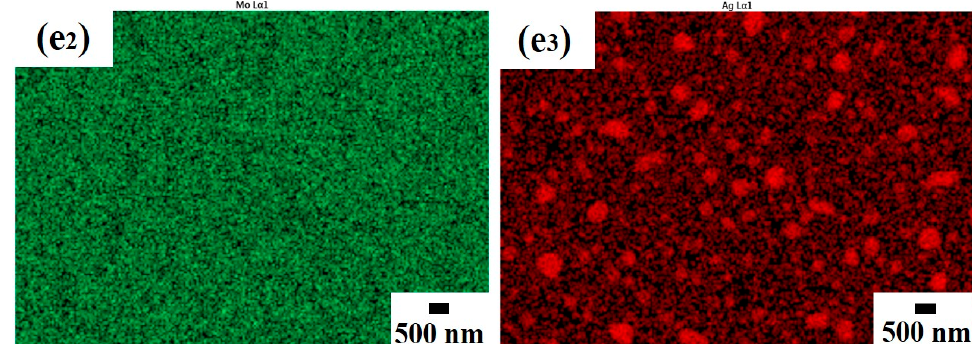
Figure 2. The scanning electron microscope (SEM) images of the Mo-48.2% Ag films before and after annealing: ( a ) room temperature; ( b ) 160 °C ; ( c ) 260 °C ; ( d ) 360 °C ; ( e ) the electronic image of Figure 2d; ( e 1 ) element mapping of Figure 2e; ( e 2 ) Mo mapping of Figure 2e 1 ; ( e 3 ) Ag mapping of Figure 2e 1 .